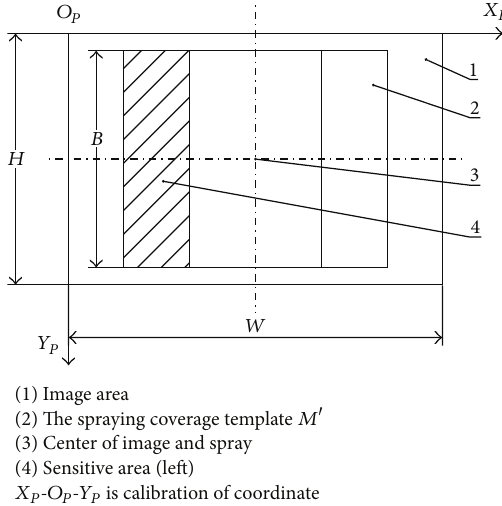
Figure 7: Sketch map of the spraying sensitive region.